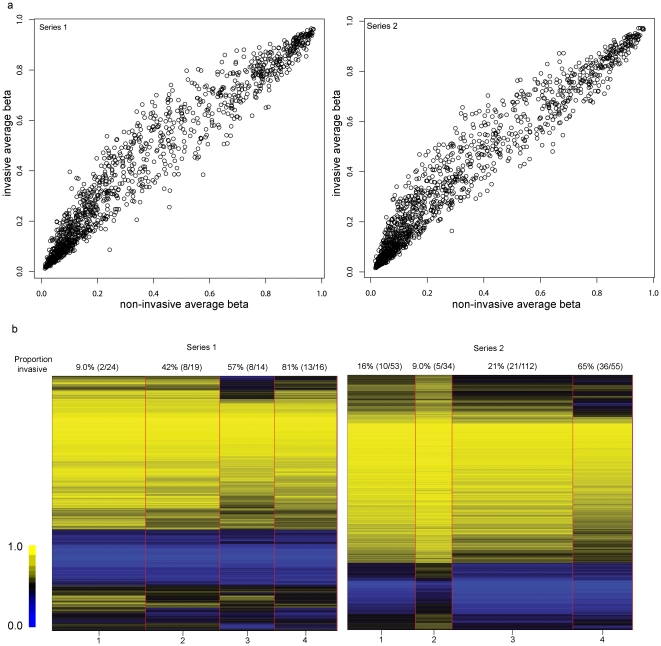
Methylation bead array profiles distinguish non-invasive and invasive bladder tumors.(A) Scatterplot of average methylation beta values in non-invasive bladder tumors (x-axis) and average methylation beta values in invasive tumors (y-axis) in series 1 (n = 73) and series 2 (n = 264) samples. (B) Recursive partition mixture models of each series result in 4 classes separated by red vertical lines, with the width of the classes corresponding to the number of samples in each class. Loci are represented as rows with the mean methylation for the class depicted. Above each class is the prevalence of invasive tumors (n invasive/total n) within the class. Methylation profiles significantly distinguish bladder tumor from non-diseased bladder epithelium (P<0.00001).